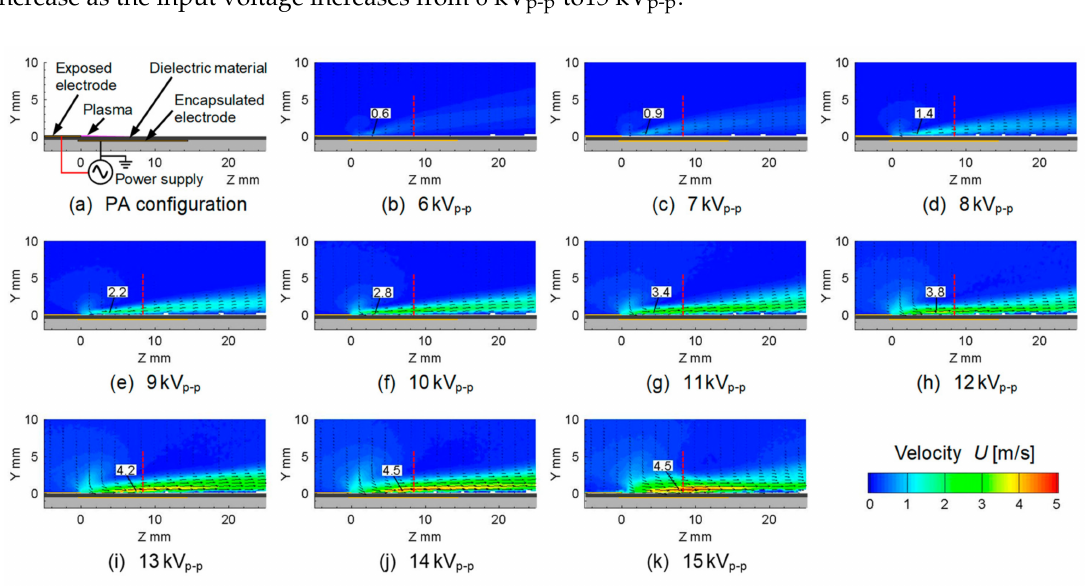
Figure 5. Absolute velocity distributions of induced flow by plasma